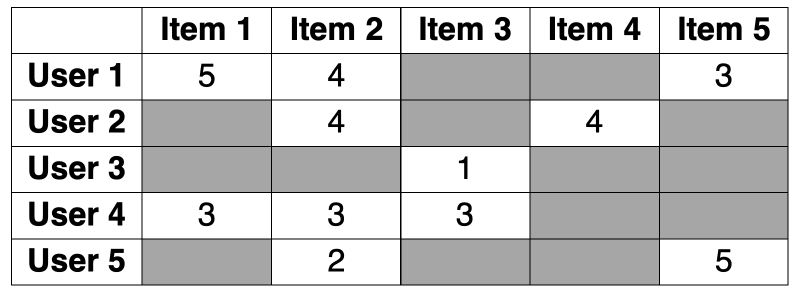
Figure 5. A sample user–item